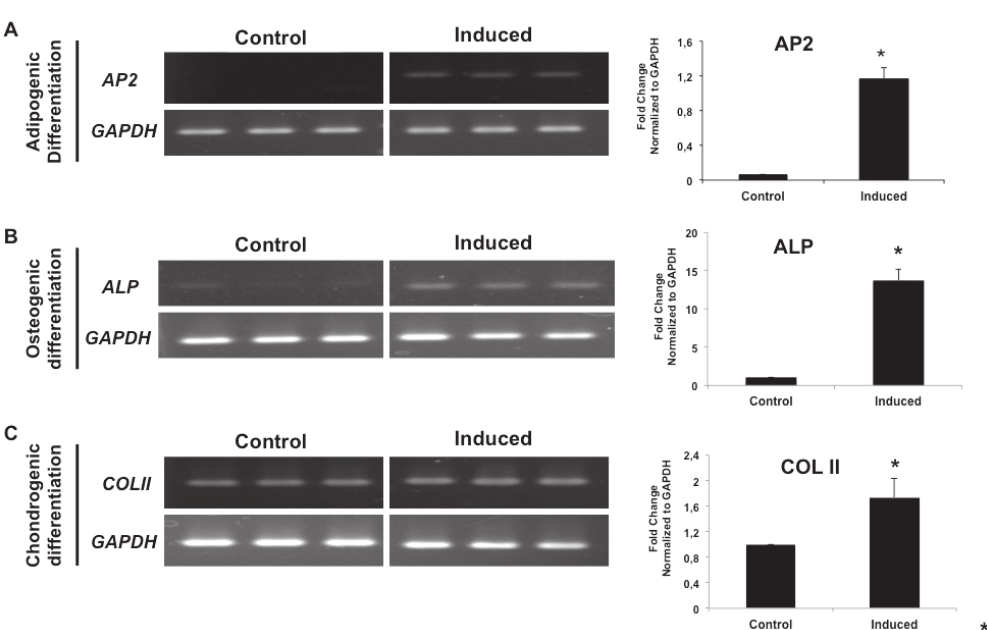
Figure 6- Expression analyses of three markers of mesenchymal stem cells from minipig BR-1 differentiated to: adipocytes (AP2), osteoblasts (ALP) and chondroblasts (COLII). Differentiation was induced over a period of 21 days, RNA was purified and the levels of the specific mRNAs were assayed by RT-PCR. The expression of GAPDH was used as a control. Data were collected from cell cultures of 3 independent animals, and reverse transcriptase-polymerase chain reaction (RT- PCR) reactions were carried out in technical triplicates, normalized to GAPDH.